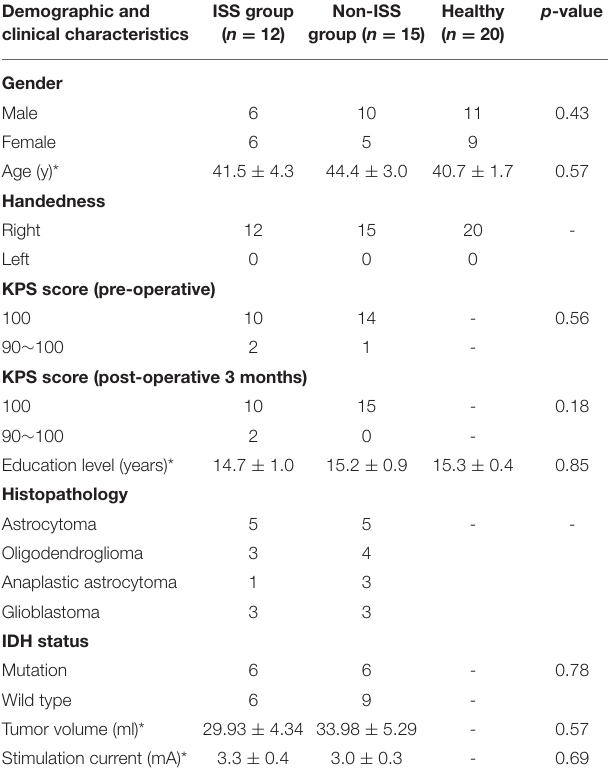
TABLE 1 | Demographic and clinical